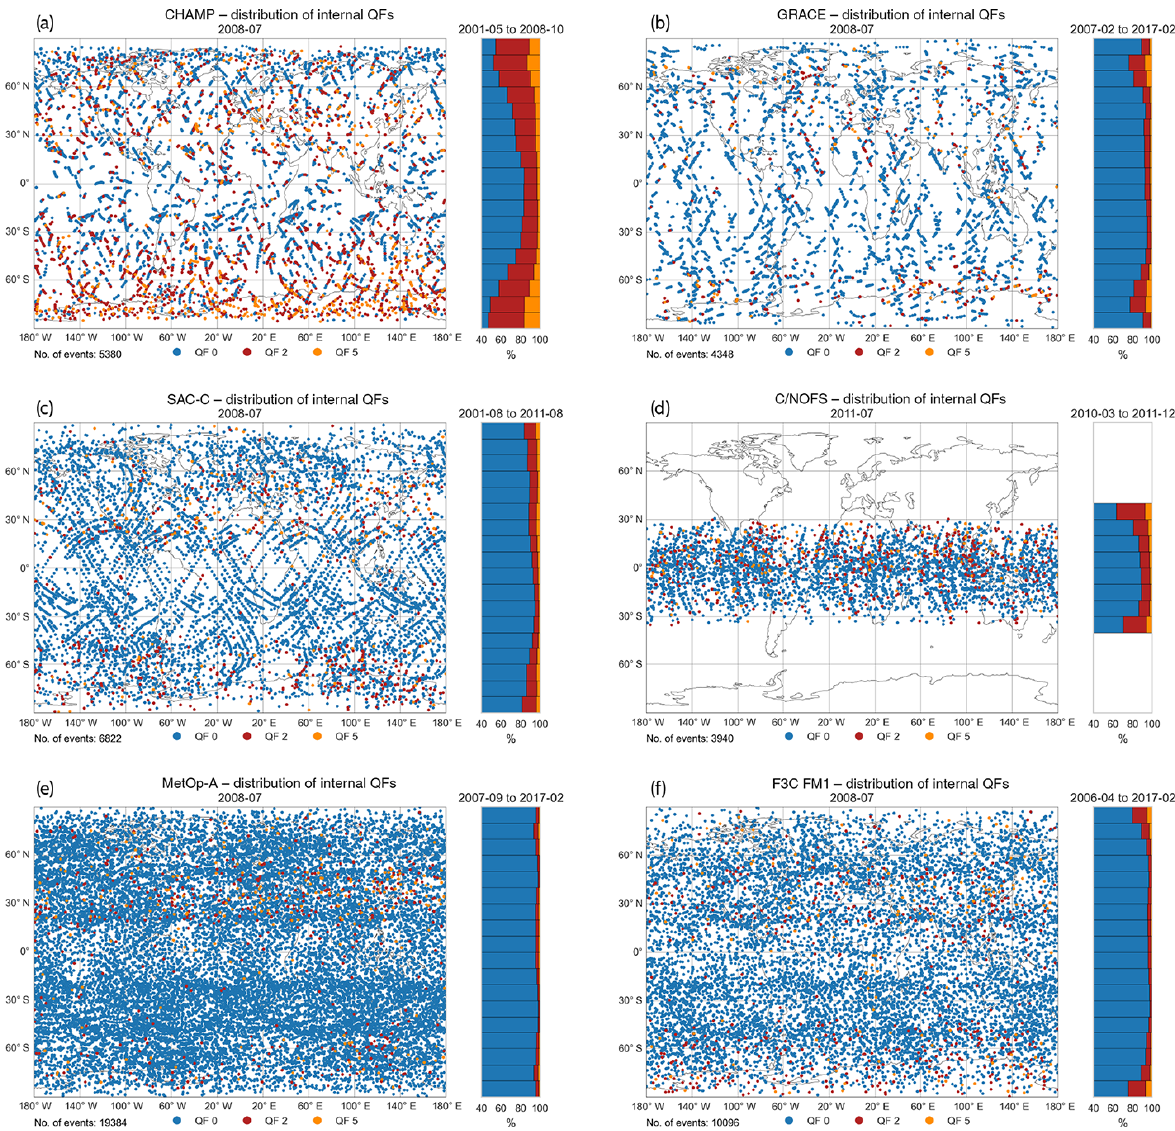
Figure 4. Spatial distribution of the RO events with bending angle QF = 0, 2, or 5 for the satellites (a) CHAMP, (b) GRACE, (c) SAC-C, (d) C/NOFS, (e) MetOp-A, and (f) F3C FM1, showing the geographical coverage for one exemplary month (left subpanels) and the latitudinal distribution over the complete available time range per satellite (right